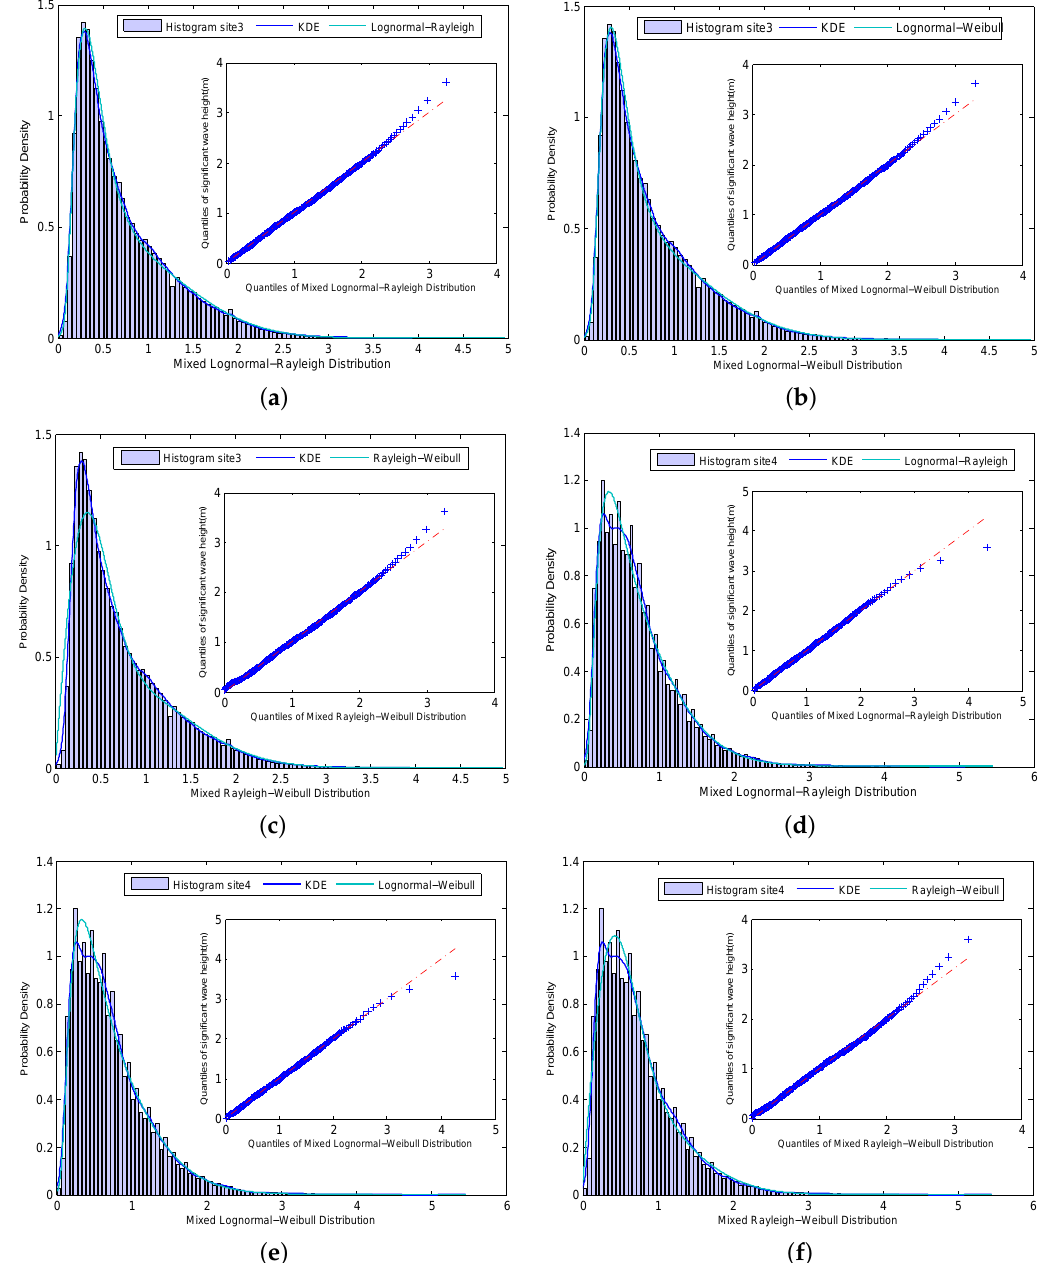
Figure 14. ( a – f ) Estimated kernel density of the significant wave heights and the mixed-distributions from Lognormal- Rayleigh, Lognormal-Weibull, and Rayleigh-Weibull distributions of the significant wave heights with the corresponding Q-Q plots of the mixed distributions of the significant wave heights for Sites 3 and